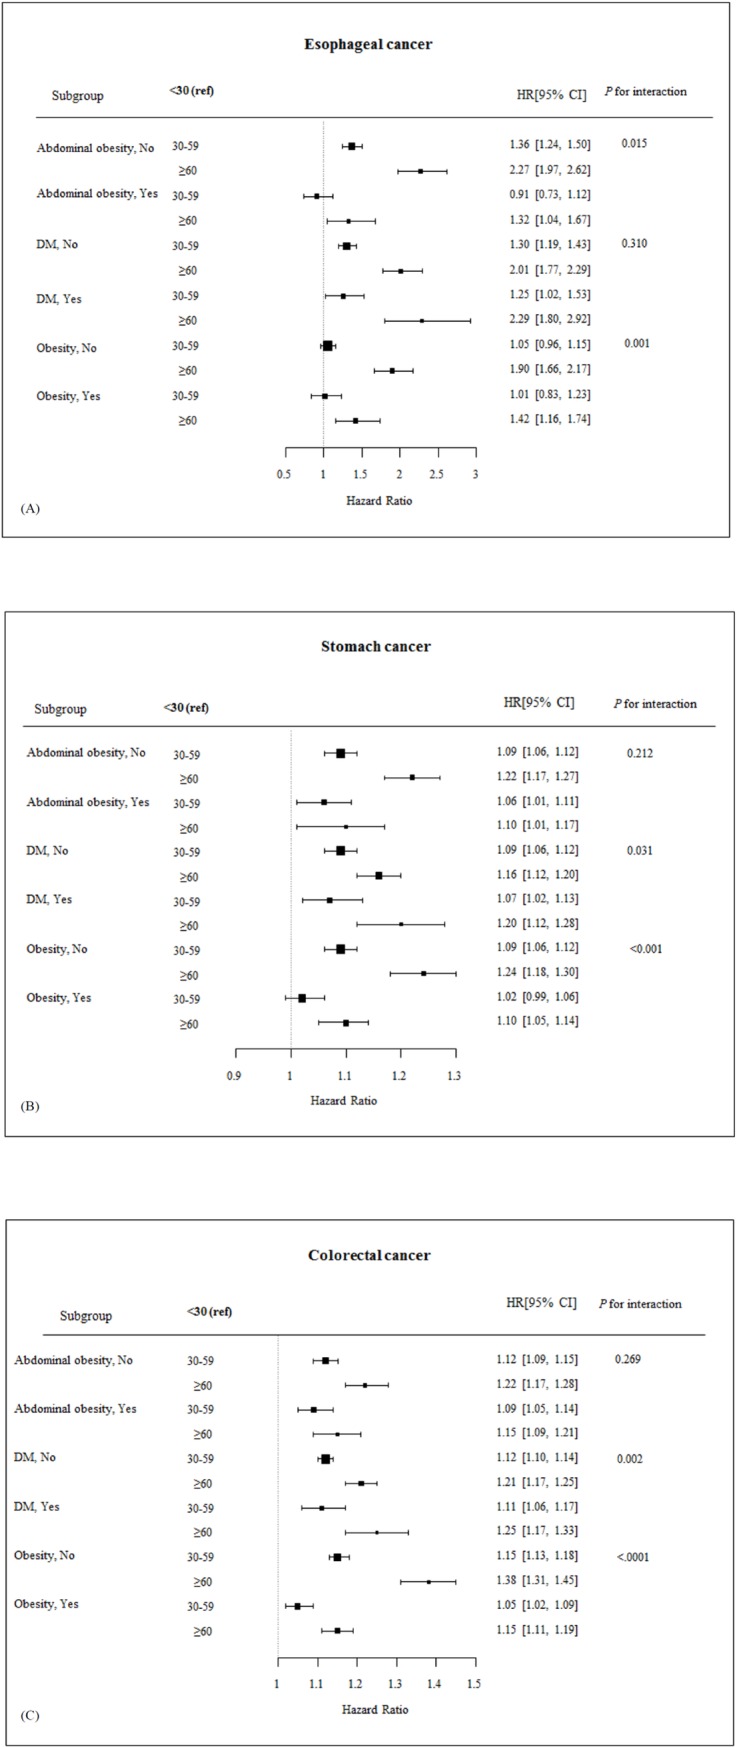
Forest plots for the association between FLI and esophageal (A), stomach (B) and colorectal cancer (C) in subgroups. All HRs adjusted for covariates including age, sex, smoking status, drinking habit, regular exercise, yearly income, BMI, and diabetes.